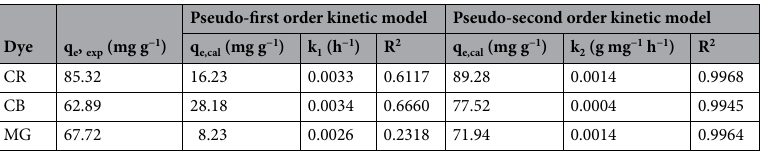
Table 4. Adsorption kinetics of CR, CB, and MG adsorptions on the FHAP-SH.